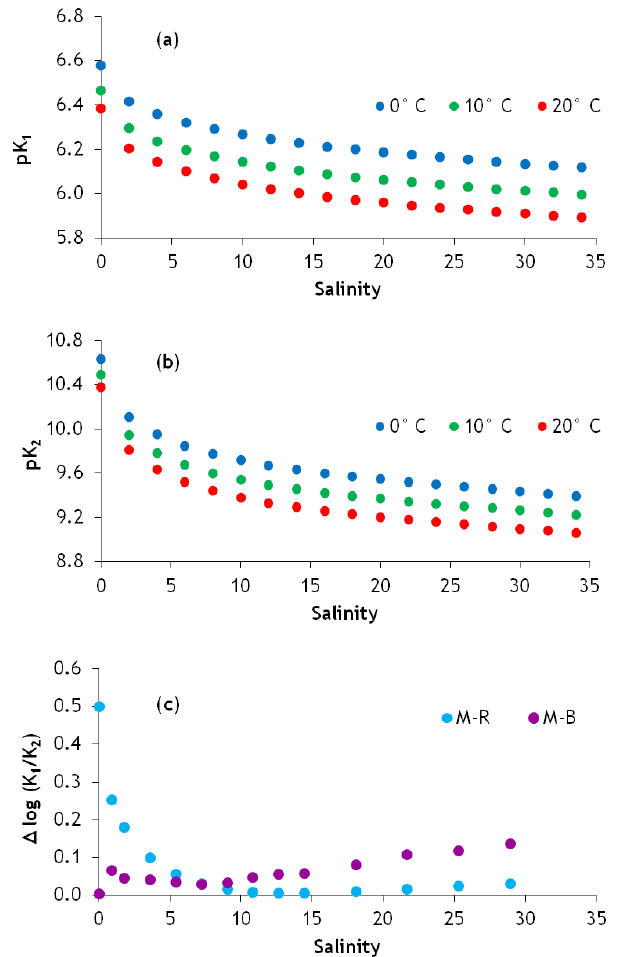
Figure 2. Dissociation constants (a) p K 1 and (b) p K 2 as a function of salinity calculated according to Millero (2010) for three different temperatures: 0, 10 and 20 ◦ C; (c) differences in log( K 1 /K 2 ) be- tween the dissociation constants obtained from Millero (2010) and Roy et al. (1993) (M-R, blue dots) and between Millero (2010) and Buch (1945) (M-B, purple dots) at different